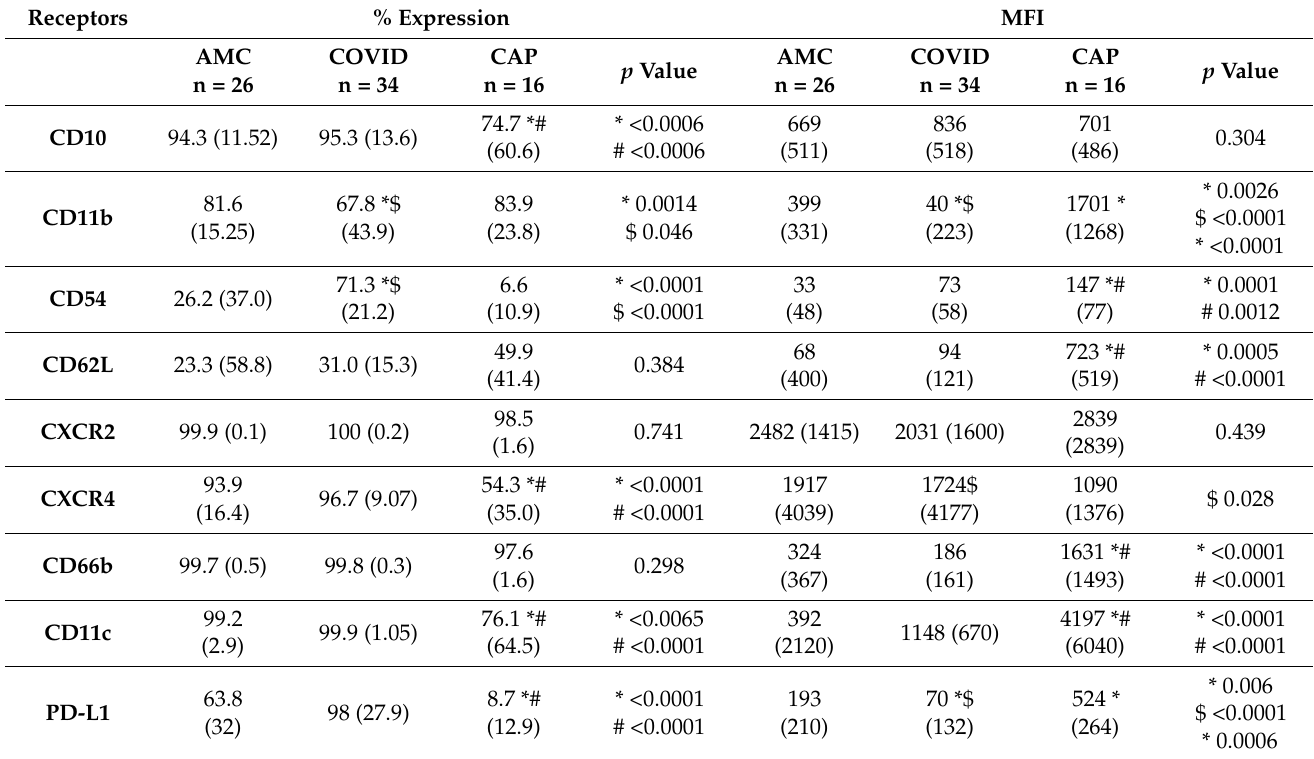
Table 2. Percentage of cells expressing, or MFI of isolated neutrophil cell surface markers measured by flow cytometry in AMC (n = 26), COVID-19 patients (n = 34) or CAP patients (n = 16). Data displayed as median (IQR). Data analyzed by individual one way ANOVA with multiple comparisons. Bold indicates significance where * vs. AMC, # vs. COVID-19 and $ vs.